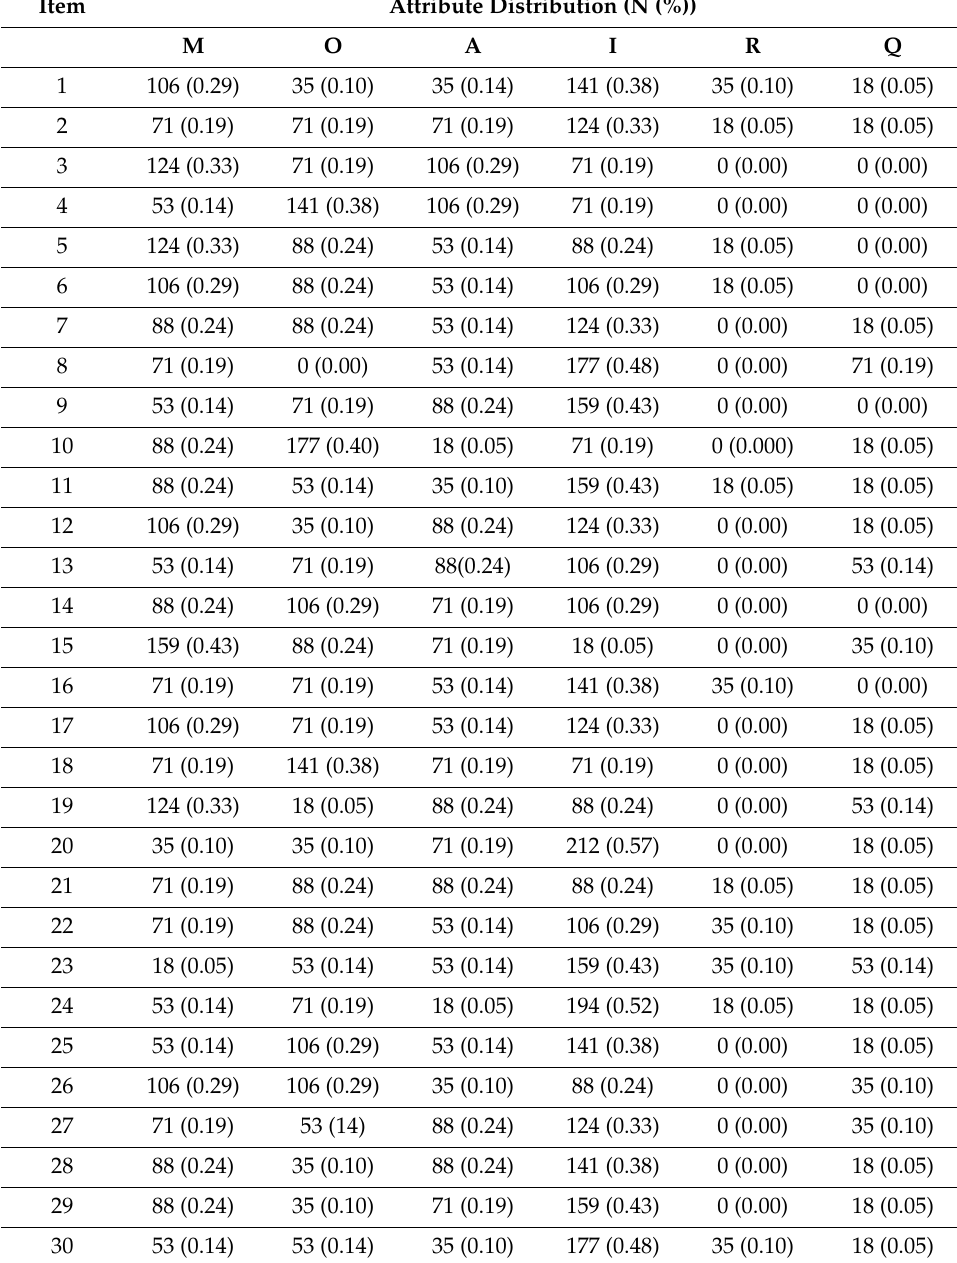
Table 6. Discrete Analysis of Attribute for smart home